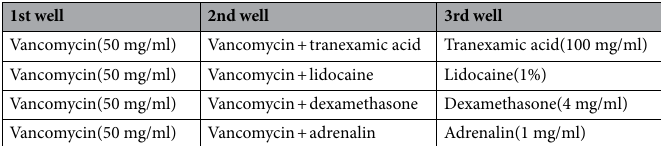
Table 1. Allocation of the substances on the plates.